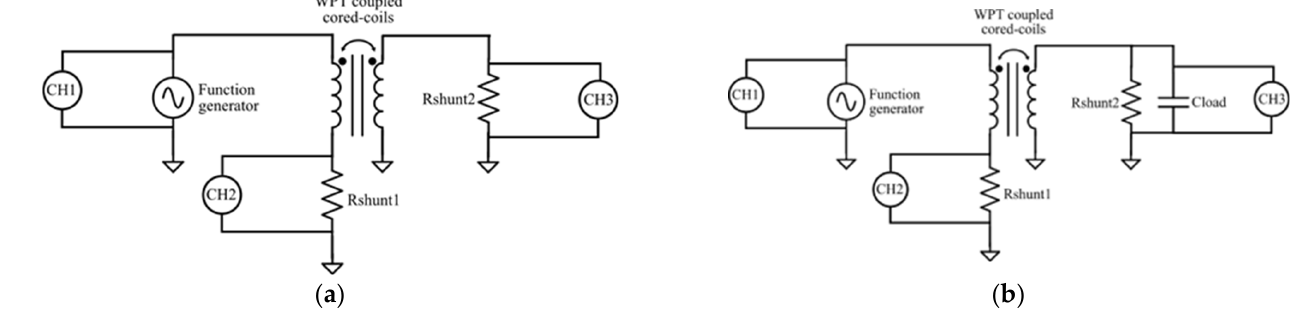
Figure 10. ( a ) Equivalent schematic of the experimental circuit for the time domain analysis; ( b ) equivalent schematic of the experimental circuit for the frequency domain analysis. Table 2. Nominal value properties of the components used during the experimental campaign. Lumped Circuit